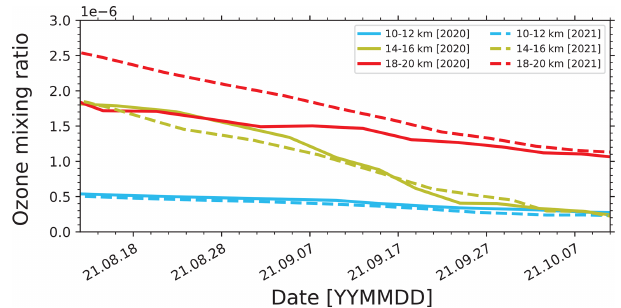
Figure 8. Temporal development of the ozone mixing ratio. Obser- vations at the Neumayer site from mid-August to mid-October in 2020 (solid lines) and 2021 (dashed lines) are used.